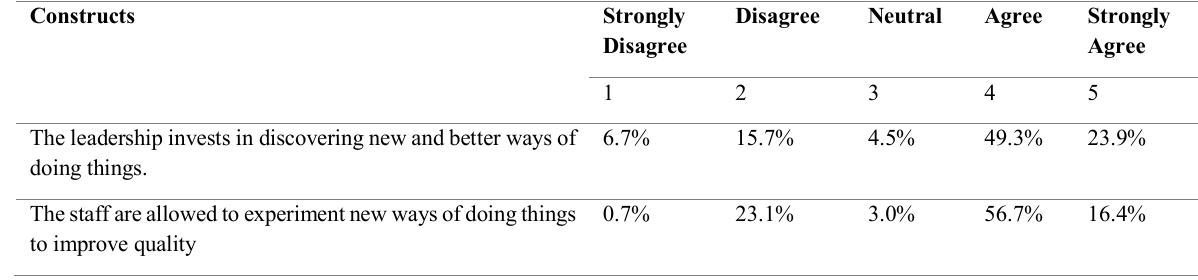
Table 5: Frequency distribution for innovativeness